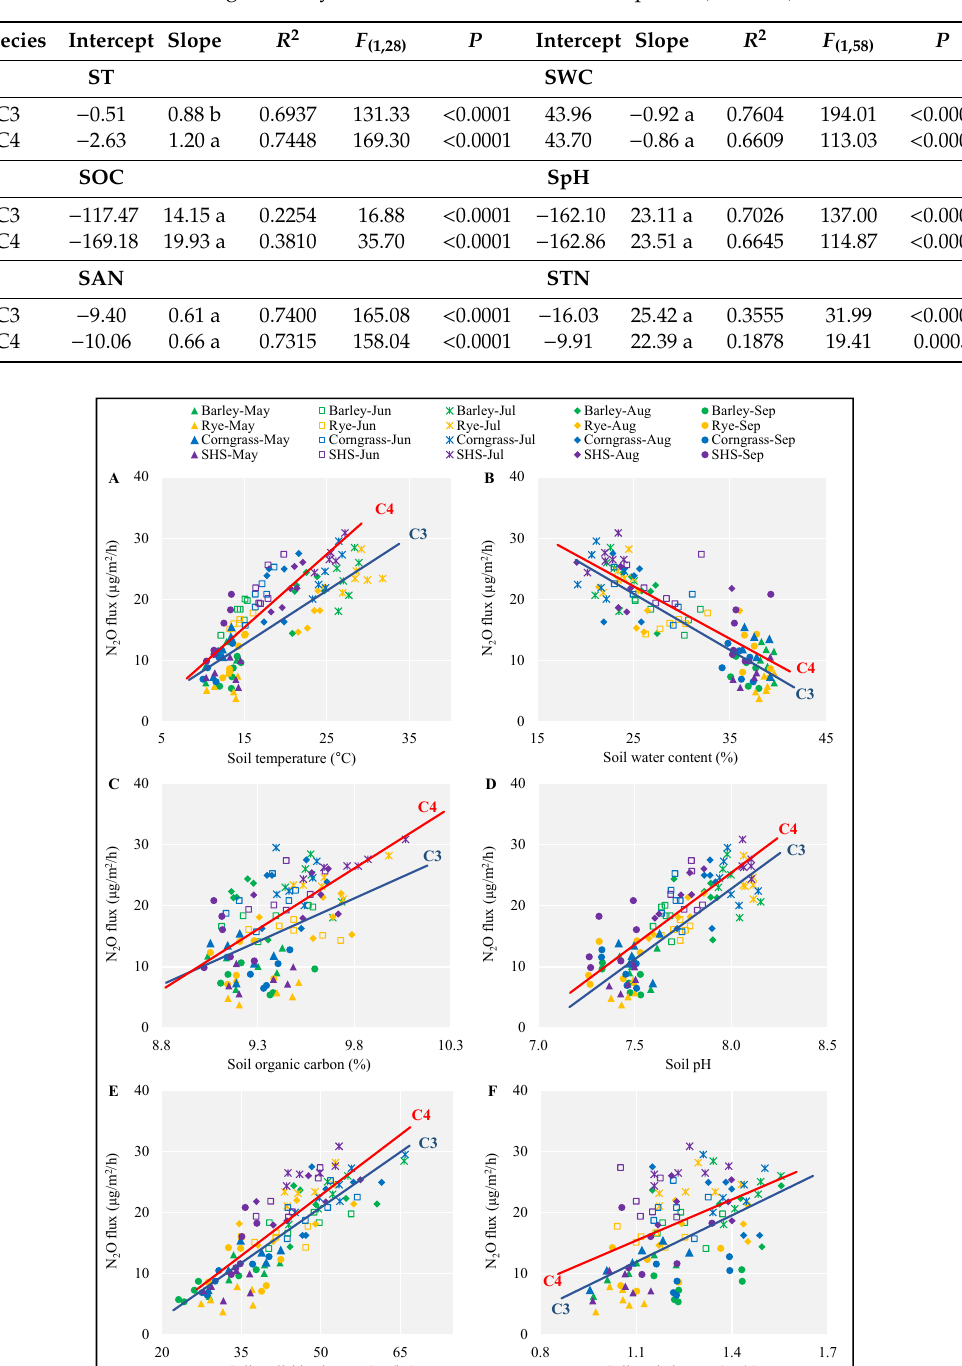
Table 3. Summary of linear regressions (Figure 3) between soil N 2 O fluxes and soil properties: soil temperature (ST), soil water content (SWC), soil organic carbon (SOC), soil pH (SpH), soil available nitrogen (SAT), and soil total nitrogen (STN) in C3 and C4 species. For each soil property, slopes with the same letters are not significantly di ff erent between C3 and C4 species ( P > 0.05).